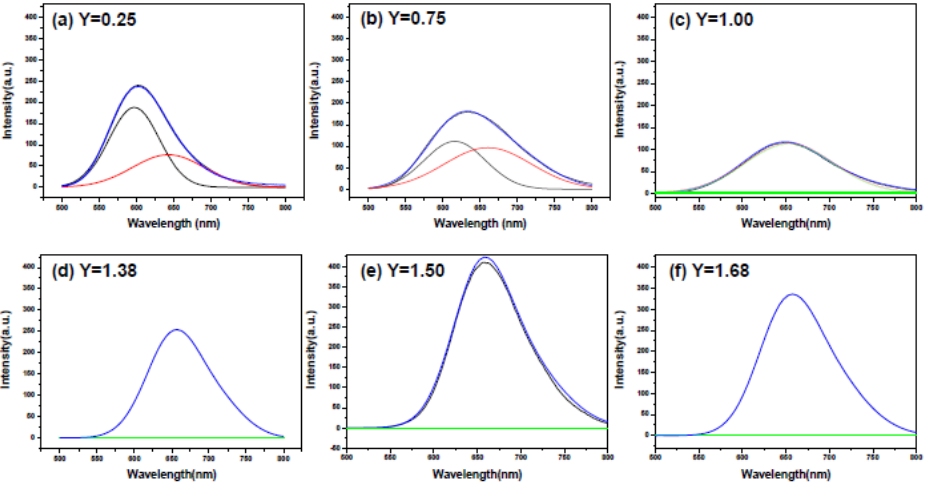
Figure 12. Gaussian deconvolution of photoluminescence emission spectra (by excitation of λ = 460 nm) of the products synthesized with various Ca contents.